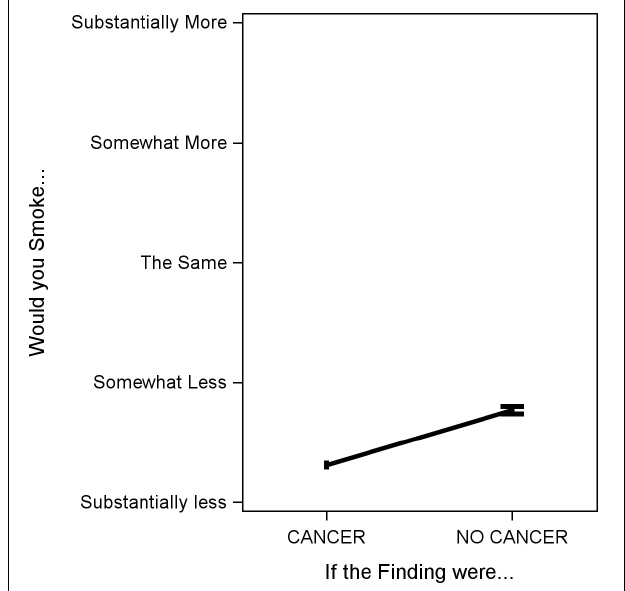
FIGURE 3 | Association between lung screen result showing cancer/not cancer and anticipated smoking behavior. The Y -axis is planned smoking behavior (0–4: smoking substantially less, somewhat less, the same, somewhat more, substantially more). The X -axis is the hypothetical finding result (cancer versus no cancer). The black line is the delta between the mean estimate for each finding with 95% confidence intervals.